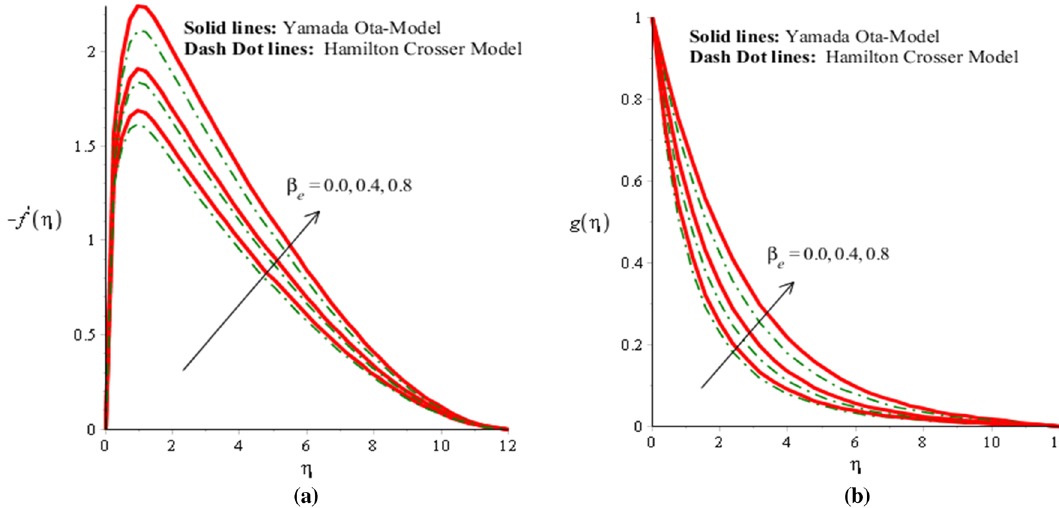
Figure 4. ( a , b ) Velocity field in y-direction and x-direction against β i when ∅ 1 = 0.002, ∅ 2 = 0.0075, (cid:31) = 2.3, α = 2.0, β i = 0.02, β = 2, Pr = 206, Ec = 0.1, H s = 0.4, M = 0.3.